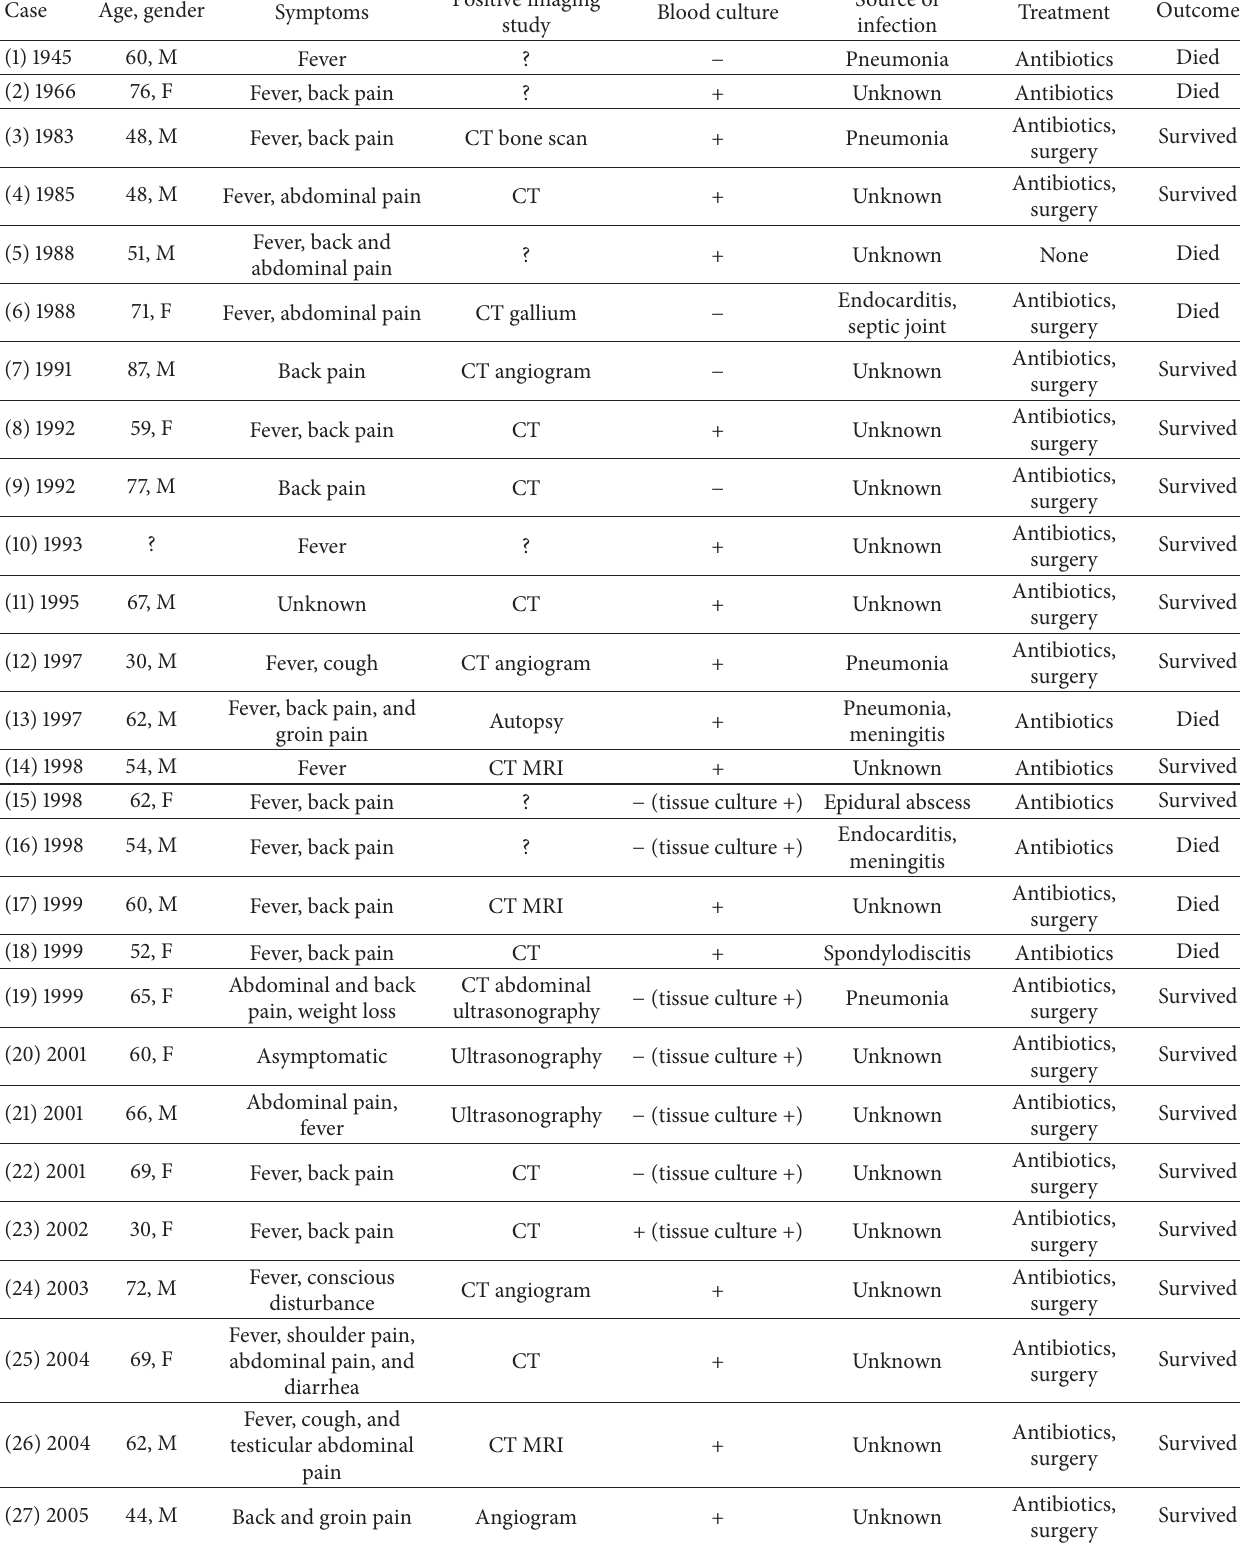
Table 1: Reported cases of infectious abdominal aortic aneurysm caused by Streptococcus pneumoniae . Case Age,